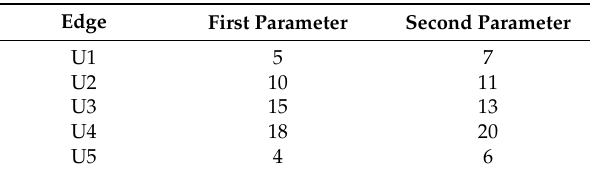
Table 2. Distribution parameters.